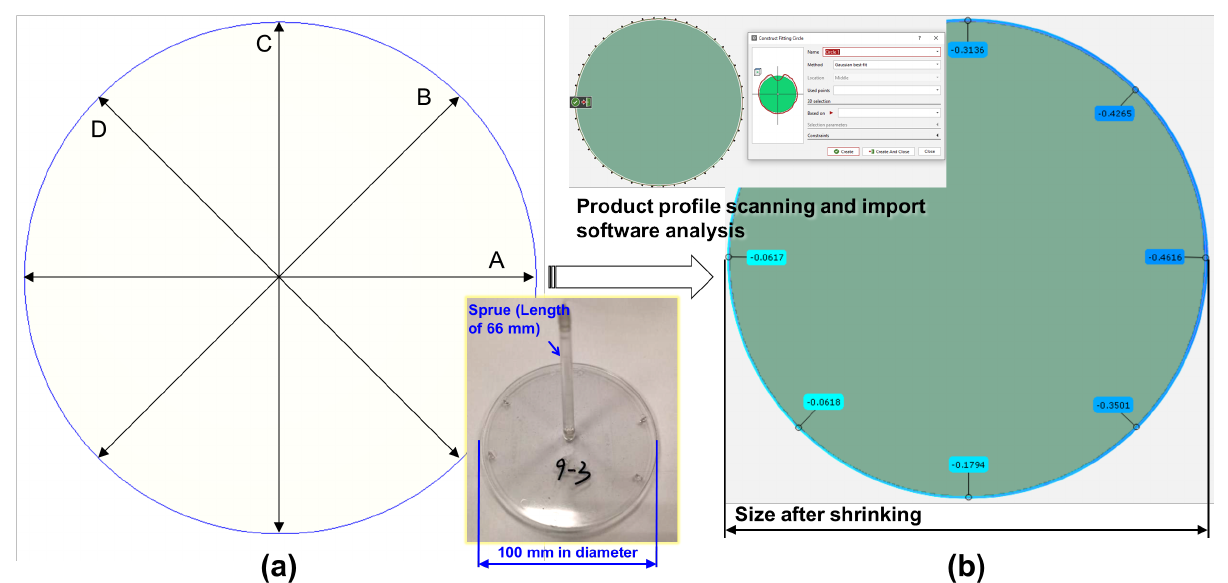
Figure 8. Schematic of the measurement of the finished product after shrinkage: ( a ) original size; ( b ) 3D − OMS measurement of the diameter of the finished product after shrinkage.